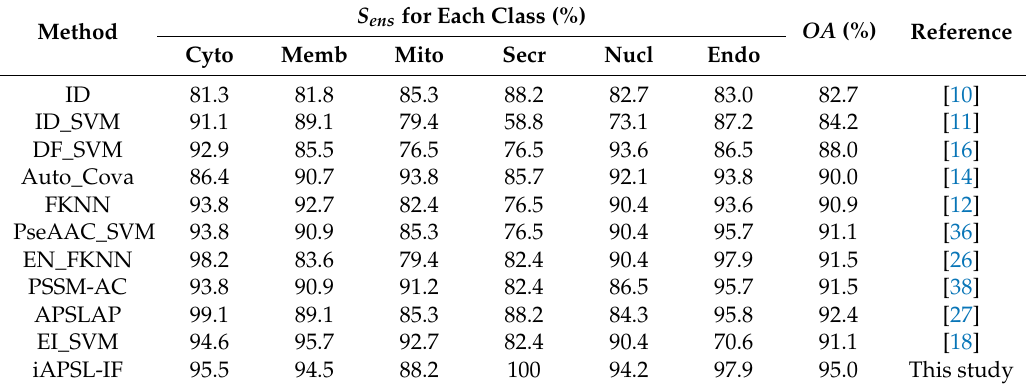
Table 3. Performance comparison of different methods on the CL317 dataset.